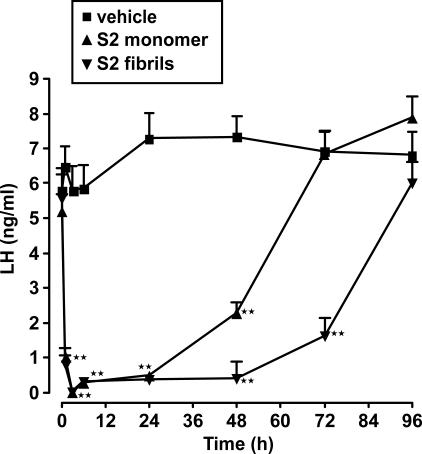
The Formation of Fibrils Inhibits LH Release in Castrated RatsTotal dose was 50 μg in 50 μl (5% mannitol). Blood samples were collected at the times shown on the abscissa. Results are illustrated as mean plasma LH levels (n = 6 rats) ± standard error of the mean (SEM). Double asterisks (**) indicate p < 0.01 versus vehicle.